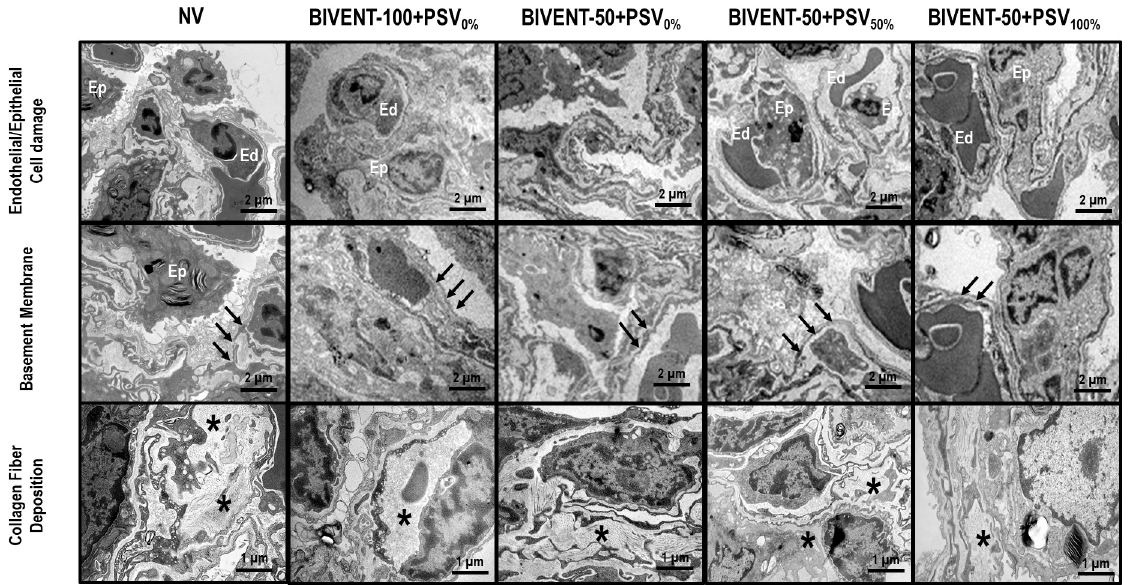
( Fig 5 ). The BIVENT-50+PSV group exhibited higher amphiregulin expression than 100% BIVENT-50+PSV animals. 0% BIVENT-50+PSV showed more myofibril abnormalities than BIVENT-50+PSV 50% BIVENT-50+PSV ( Fig 6, Table 4 ). The mitochondrial injury score was higher in 100% BIVENT-50+PSV than BIVENT-50+PSV and BIVENT-50+PSV 50% 0% expression was higher in BIVENT-50+PSV than in BIVENT-50+PSV 50% PSV ( Fig 7 ). No significant changes were observed in MAFbx expression among BIVENT- 100% 50 groups ( Fig 7 ).